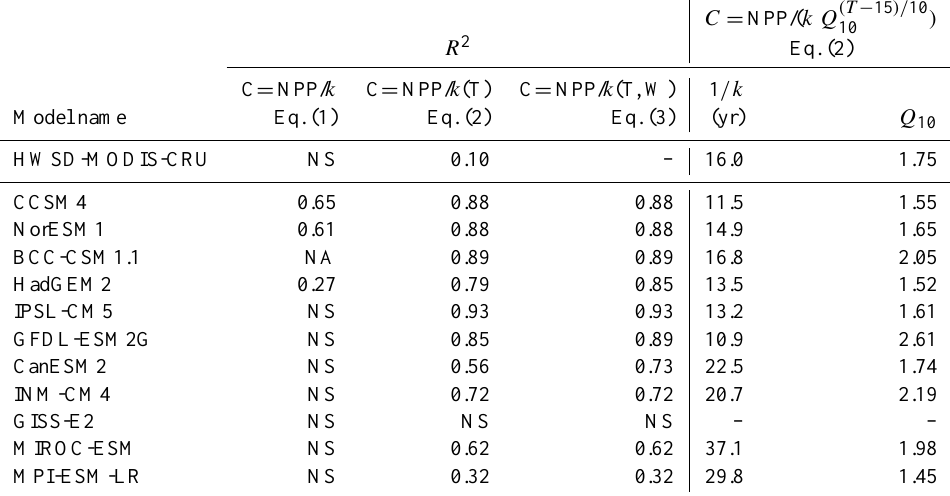
Table 4. Coefficients of determination ( R 2 ) and global-scale parameters (1 /k and Q 10 ) from reduced complexity models of ESM soil carbon distributions. Eq. (1): dependence on NPP; Eq. (2): dependence on NPP and soil temperature; Eq. (3): dependence on NPP, soil temperature, and soil moisture. Parameters are shown from Eq. (2) with 1 /k analogous to turnover time. HWSD-MODIS-CRU represents reduced complexity models based on observational data. The reduced complexity model for CanESM2 was the only one improved by including soil moisture and had a turnover time (1 /k ) of 8.20yr, Q 10 of 1.48, and moisture exponent of 0.46 based on Eq. (3). All R 2 values were statistically significant ( R 2 > 0 . 05, p < 0 . 01 ) unless otherwise indicated